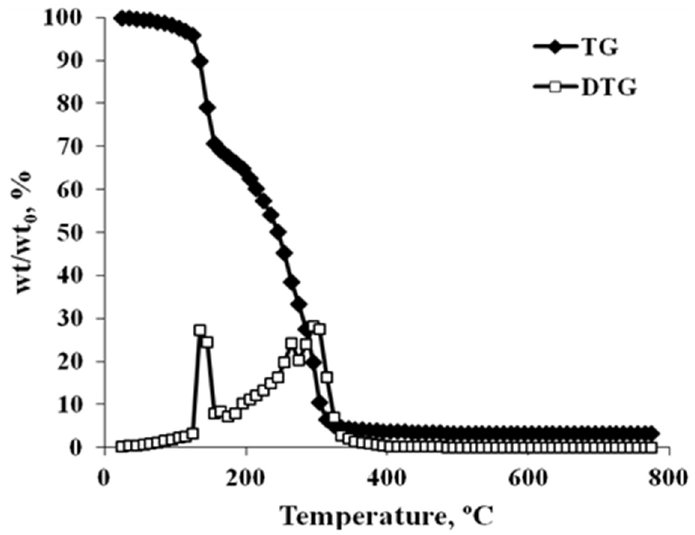
Figure 2. Weight loss against temperature (TG) and its derivative (DTG) profiles of glycerin’s thermal decomposition.